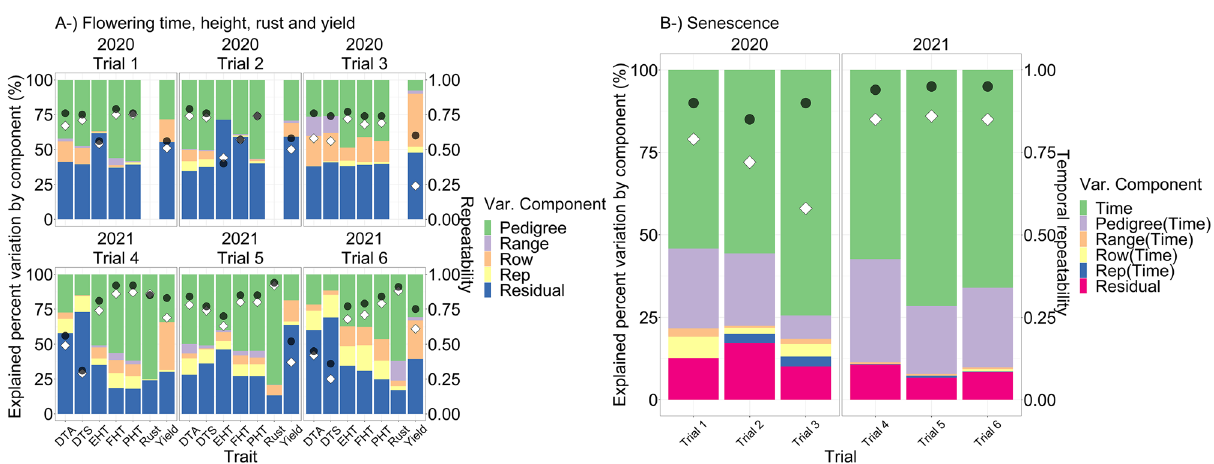
Figure 6. ( A ) Explained percent variation for flowering times (days to anthesis and silking: DTA and DTS), three different plant heights (plant heights from ground to tip of tassel: PHT, to collar of flag leaf: FHT and to shank of first ear: EHT) in each trial in both years based on left Y axis. ( B ) Explained percent variation for senescence for each trial in each year. Black circles indicate the R-squared value and white diamonds indicate the repeatability for flowering times, heights, rust, yield, and temporal repeatability for senescence based on right Y